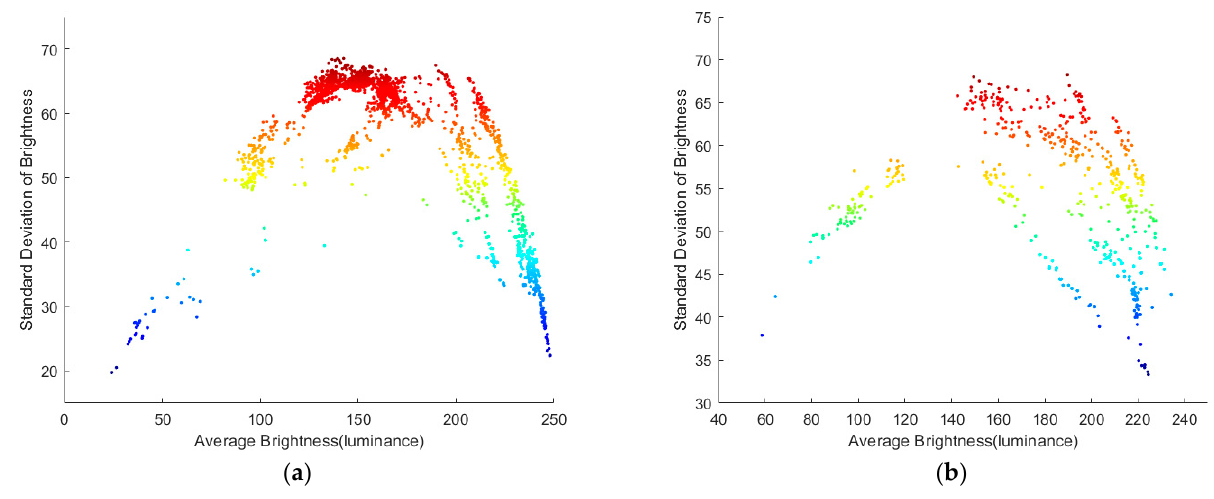
Figure 2. Distribution of image brightness of the datasets: ( a ) training data and ( b ) test data.